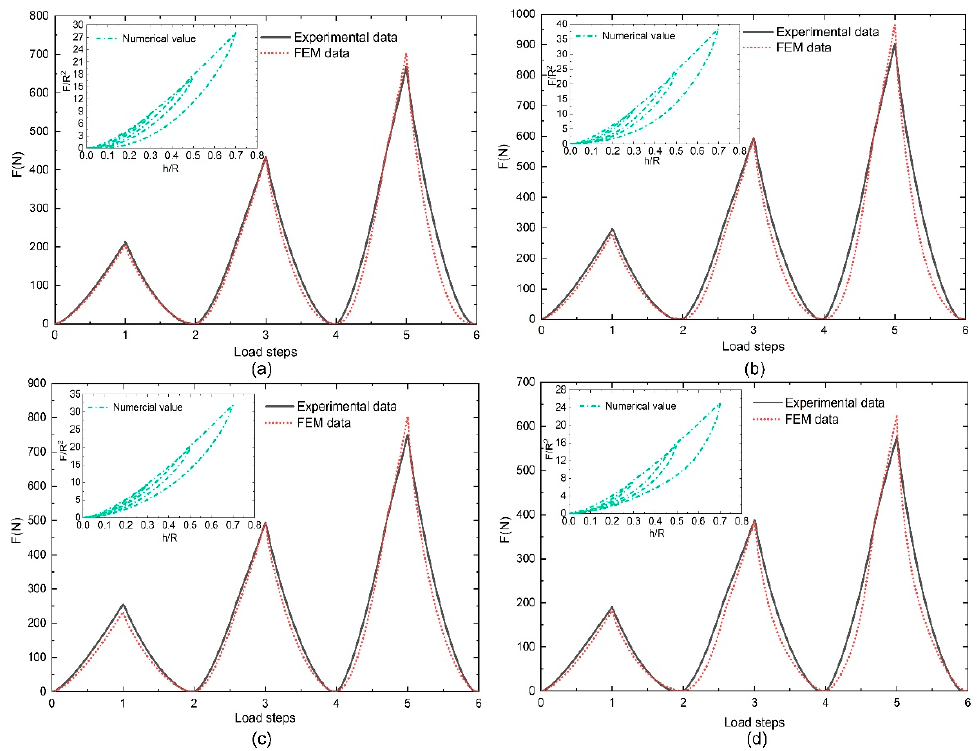
Figure 8. The numerical load steps and load–displacement curves for the nanoparticle-filled polyurethanes (NPFPUs): ( a ) filled with 5 phr nano-silica; ( b ) filled with 10 phr nano-silica; ( c ) filled with 5 phr carbon black (CB); and ( d ) filled with 10 phr CB.